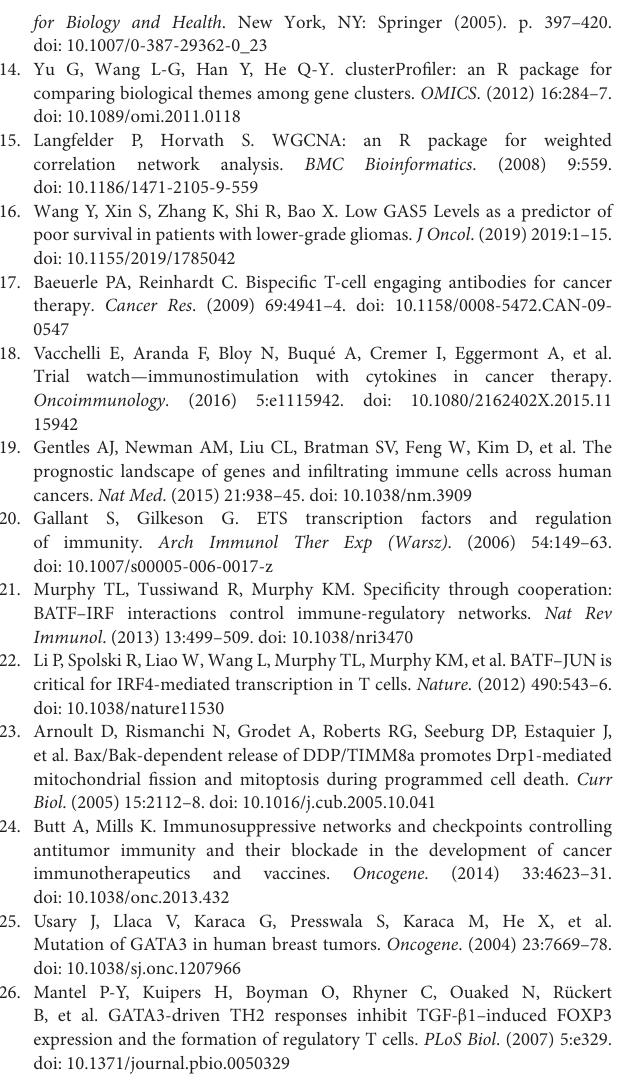
the ssGSEA scores of DCs and the OS probability of IDC patients in the high-risk score group. Figure S8 | The ssGSEA score distribution in the low, intermediate, and high immune infiltration patterns and in the low- and high-risk score groups. (A) The ssGSEA score distribution in low, intermediate and high immune infiltration patterns. (B) The difference and P -value from the comparison between the ssGSEA score from low and high immune infiltration patterns. (C) The ssGSEA score distribution in the low- and high-risk score groups. (D) The difference and P -value from the comparison between the ssGSEA score from the low- and high-risk score group. (E) The distribution of immune infiltration patterns in different pathological subtypes. (F) The distribution of risk scores in different pathological subtypes. (G) The distribution of immune infiltration patterns at different pathological stages. (H) The distribution of risk scores at different pathological stages. Figure S9 | The selection of the soft threshold in the WGCNA. (A) Scale free topology model fit, (B) mean connectivity. Figure S10 | The correlation of the expression profiles of several immune checkpoint proteins, risk score, and VEGF-A in the TCGA (A) cohort and GSE20685 cohort (B)